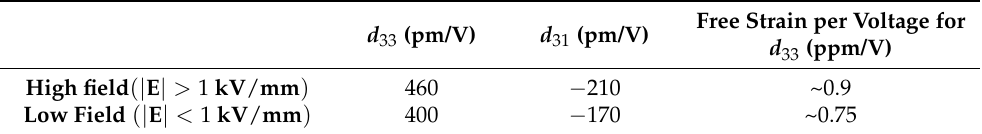
Table 2. Piezoelectric strain constants for high and low